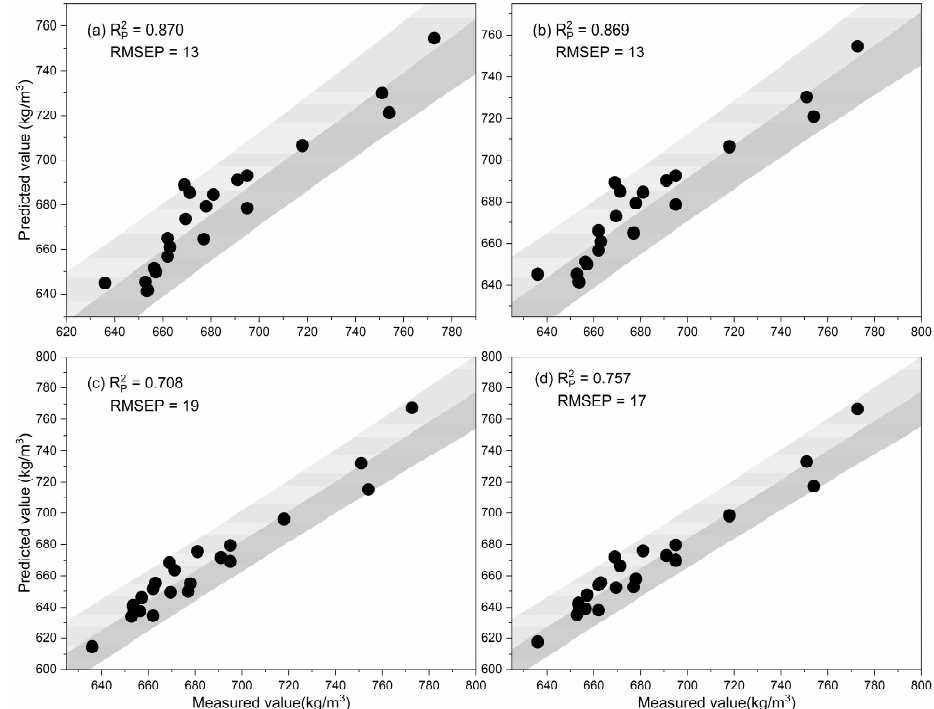
Figure 5. The results of the GRNN and PSO-SVM models with characteristic bands. ( a ) GRNN model with raw spectra; ( b ) GRNN model with LWT de-noising; ( c ) PSO-SVM model with raw spectra; ( d ) PSO-SVM model with LWT de-noising.